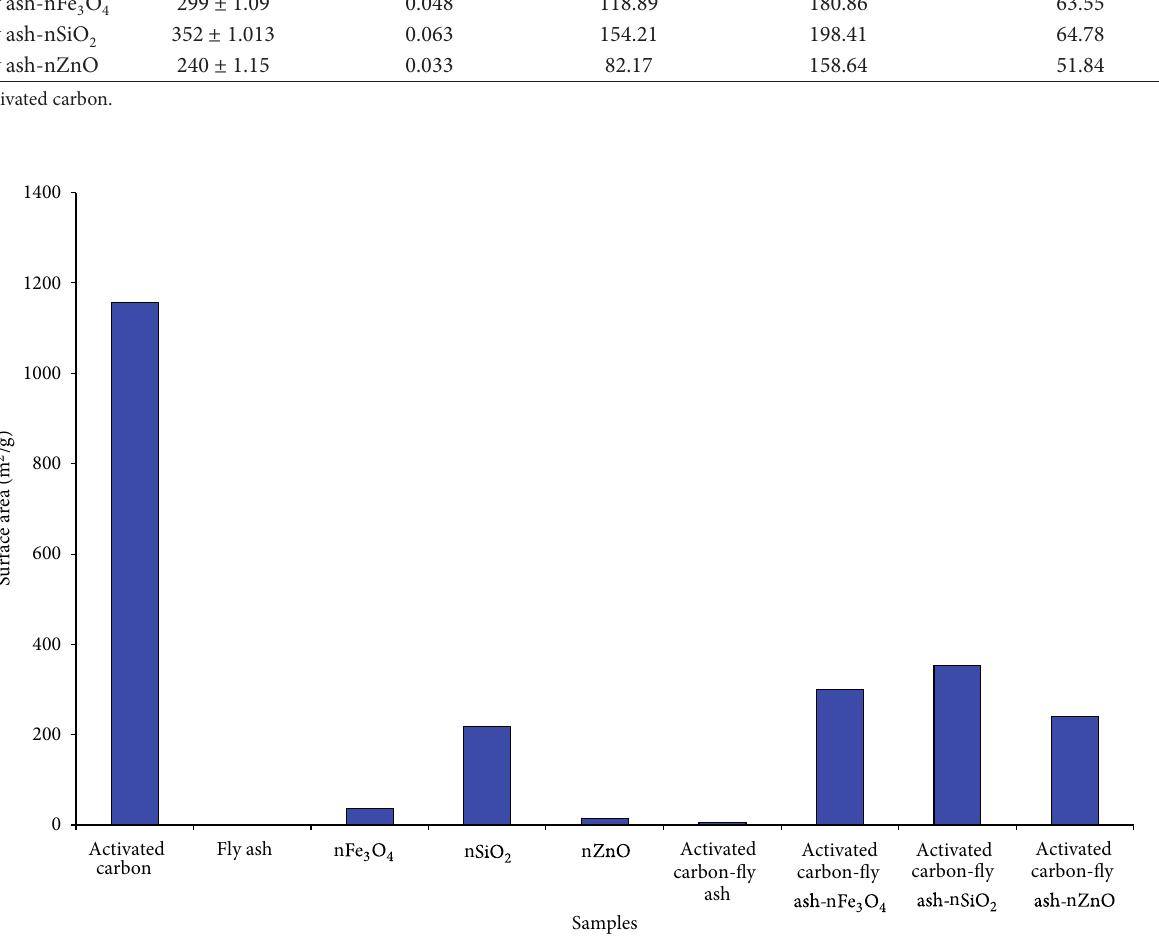
F 26: Surface area (m